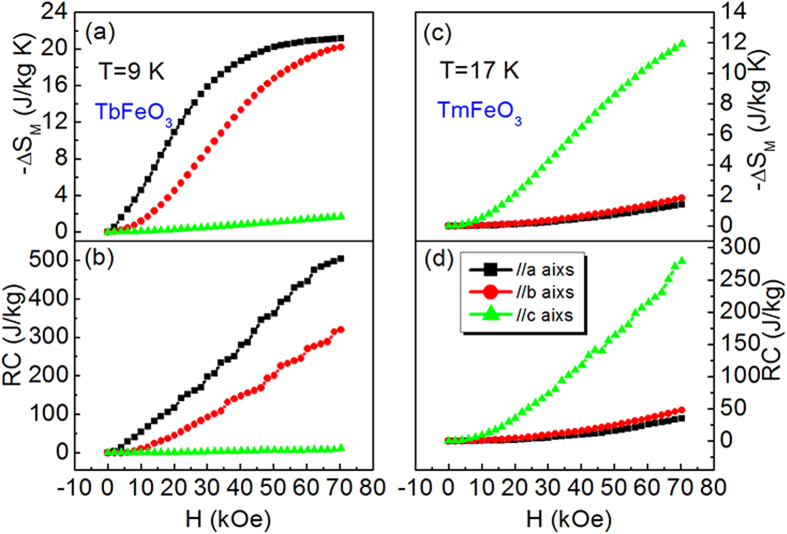
Calculated−ΔSM and refrigeration capacity (RC).(a) field dependence of magnetic entropy changes of TbFeO3 along a, b and c axis at 9 K, and (b) refrigeration capacity; (c) field dependence of magnetic entropy change of TmFeO3 along a, b and c axis at 17 K, and (d) refrigeration capacity.